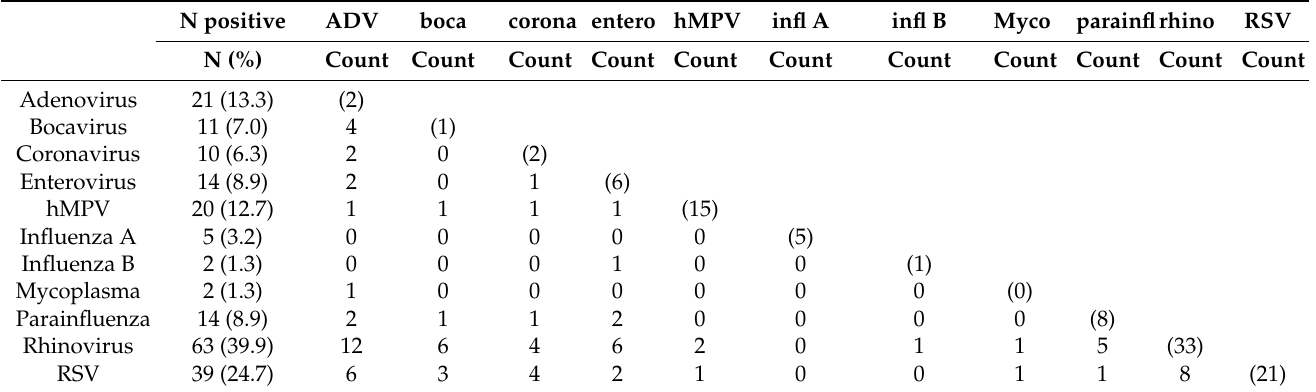
Table 2. Viral/mycoplasma infections and co-infections detected by